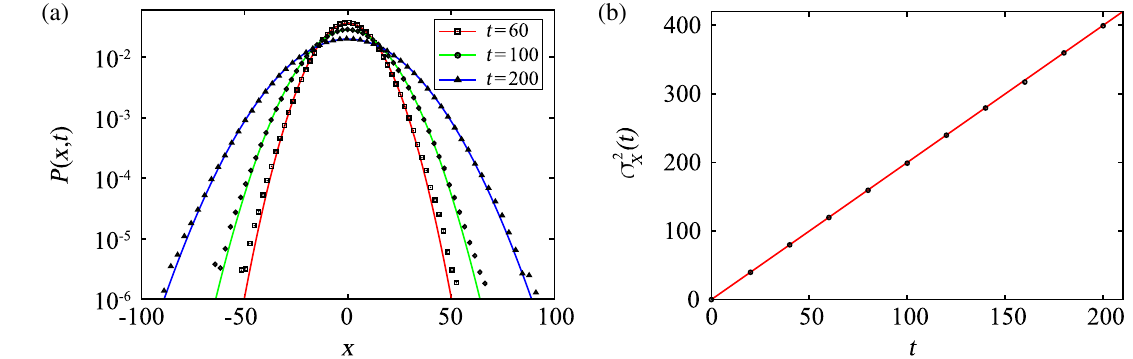
FIG. 4. Long-time diffusive properties of the EPK model Eq. (40). Here, we consider only the transition rate λ ¼ 10 , and all the other model and simulation parameters are the same as in Fig. 3; see also the text. Symbols correspond to the results of stochastic simulations. (a) Position probability density function P ð x; t Þ at different times t as given in the legend. Lines represent the Gaussian long-time limit Eq. (45). (b) Mean square displacement σ 2 x ð t Þ . The solid line corresponds to the Einsteinian scaling σ 2 x ð t Þ ¼ 2 D